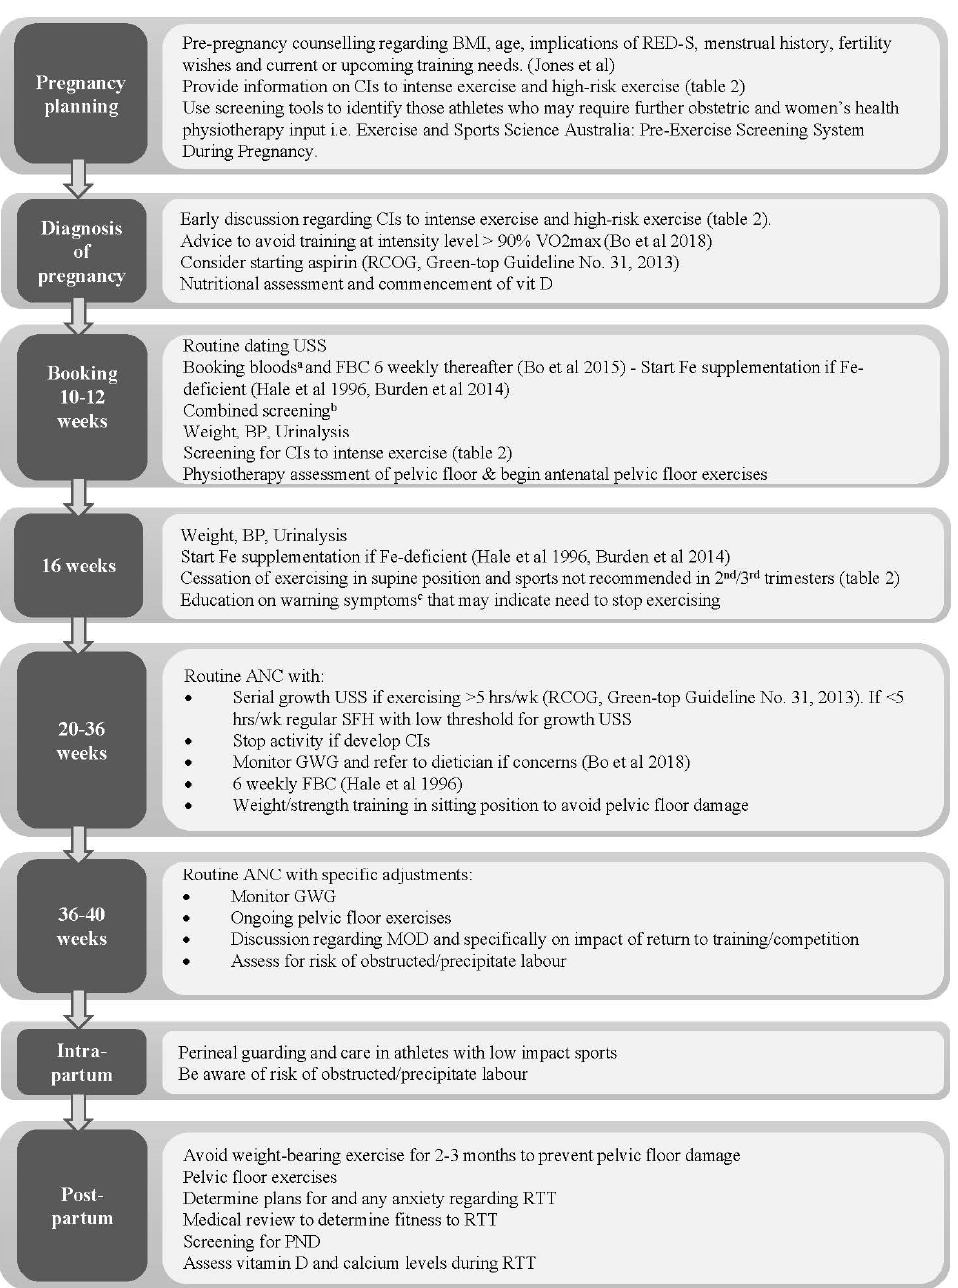
Figure 1. Guidance for obstetricians managing athletes during the preconception, antenatal and postnatal periods: ANC; antenatal care, BP; blood pressure CI; contraindication, FBC; full blood count, Fe; iron, GWG; gestational weight gain, hrs/wk; hours per week, MOD; mode of delivery; PND; postnatal depression, RED-S; relative energy deficiency in sport, RTT; return to training; USS; ultrasound scan, VO2 max; maximum oxygen consumption [11,13,65,66,83]. a Booking bloods; FBC, Group and save, Syphilis, Hepatitis B, HIV, urea & electrolytes, glucose, iron studies, B12, folate b Combined screening; Nuchal Translucency (NT)/Pregnancy Associated Plasma Protein A (PAPP-A)/hCG c Warning symptoms [42] : Vaginal bleeding, regular painful contractions, leakage of amniotic fluid, dyspnoea before exercise, pre-syncopal symptoms or syncope, headache, chest pain, muscle weakness, calf